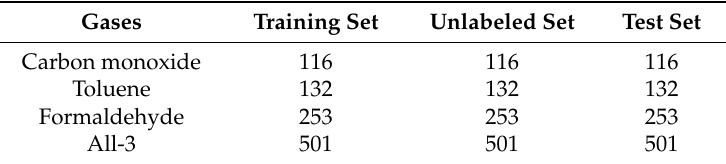
Table 2. Amount of samples in a data set with 50% unlabeled rate.